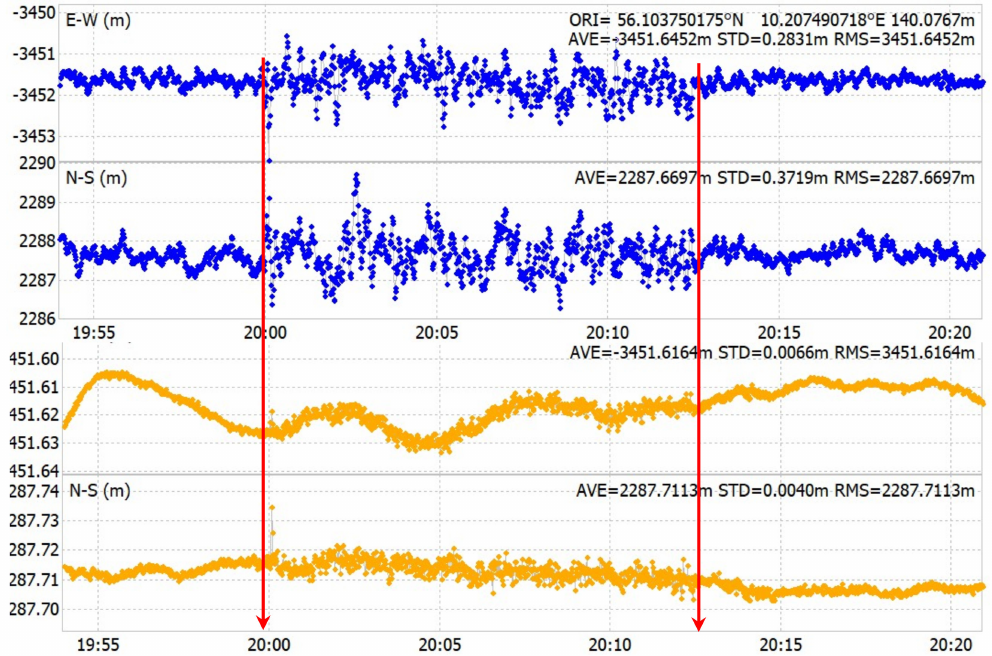
Figure 9. East and north components of the baseline vector for the DGPS (top) and PPK float (bottom) solutions in Case 3, baseline 1, using only L1 data from select satellites (G07, G10, G16, G20, G21, G26, and G27). Red arrows mark the jamming interval. Note the meter-level zoom on the y-axis in the top plot, and cm-level zoom in the bottom